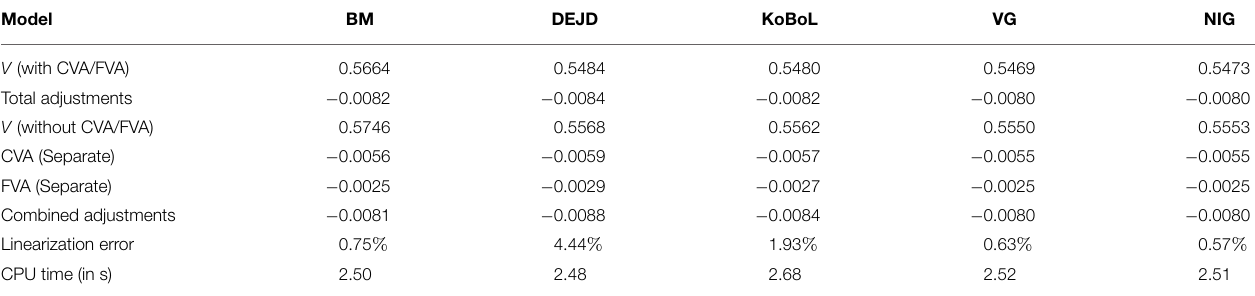
TABLE 5 | Prices of at-the-money digital put for different models as of 9 January 2015, time to maturity T = 0 . 463 , spot, strike S = K = 24 , 000 , risk-free rate r = 0 . 52 % , collateral rate r C = 1 % , funding rate r F = 1 . 7 % default intensity λ = 0 . 05 , recovery rate R B = 0 . 4 , collateral threshold H B = 0 . 5 . Model